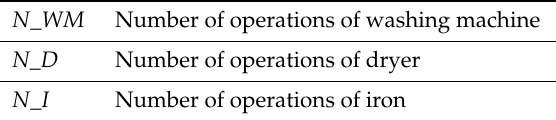
Table 2. Definition of parameters in (2), (3), and